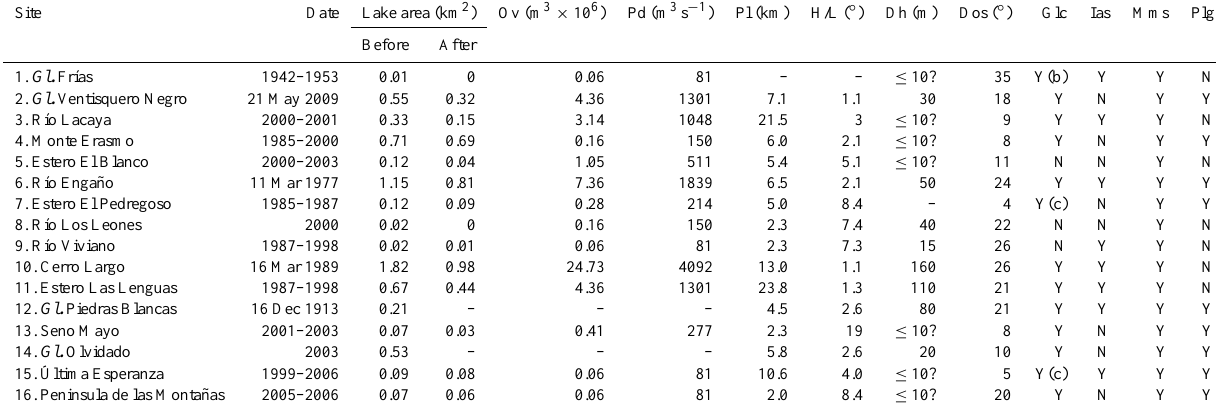
Table 1. Data of 16 GLOFs in Patagonia and characteristics of the moraine-dammed lakes and their surroundings prior to the failure. Site